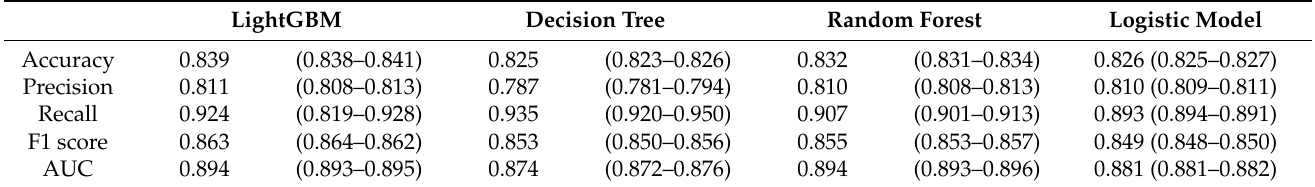
Table 3. Machine learning and logistic model-based prediction models for litigation outcomes in all